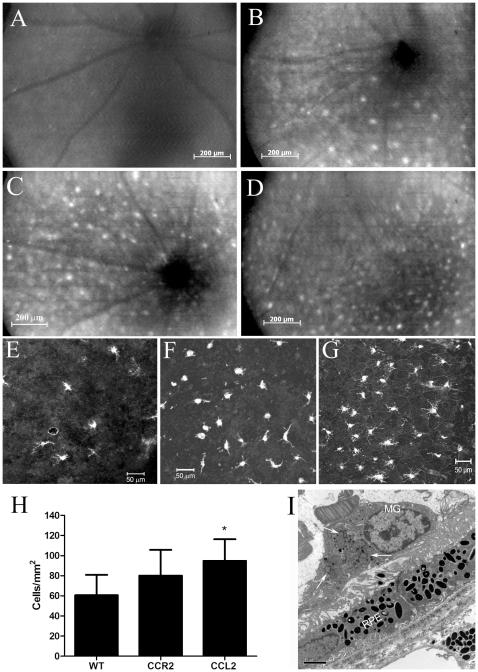
Subretinal microglia in different strains of mice.A–D, Autofluorescent (AF) images of a 3-month WT mouse (A), a 24-month WT mouse (B), a 24-month old CCR2 KO mouse, (C) and a 24-month CCL2 KO mouse (D). E–G, confocal images of RPE flatmounts stained for microglia with Iba-1 antibody (see Methods) from a 20-month old WT mouse (E), a 20-month old CCR2 KO mouse (F) and a 20-month old CCL2 KO mouse (G). (H) The number of subretinal Iba-1+ microglia in 20-month old of different strains of mice. Mean ± SD, N = 8∼12. *, P<0.05 compared to WT, ANOVA Dunn's multiple comparison test. I, a TEM image from a CCL2 KO mouse showing a subretinal microglial cell (MG) with lipofuscin (arrows) on the surface of RPE cells.